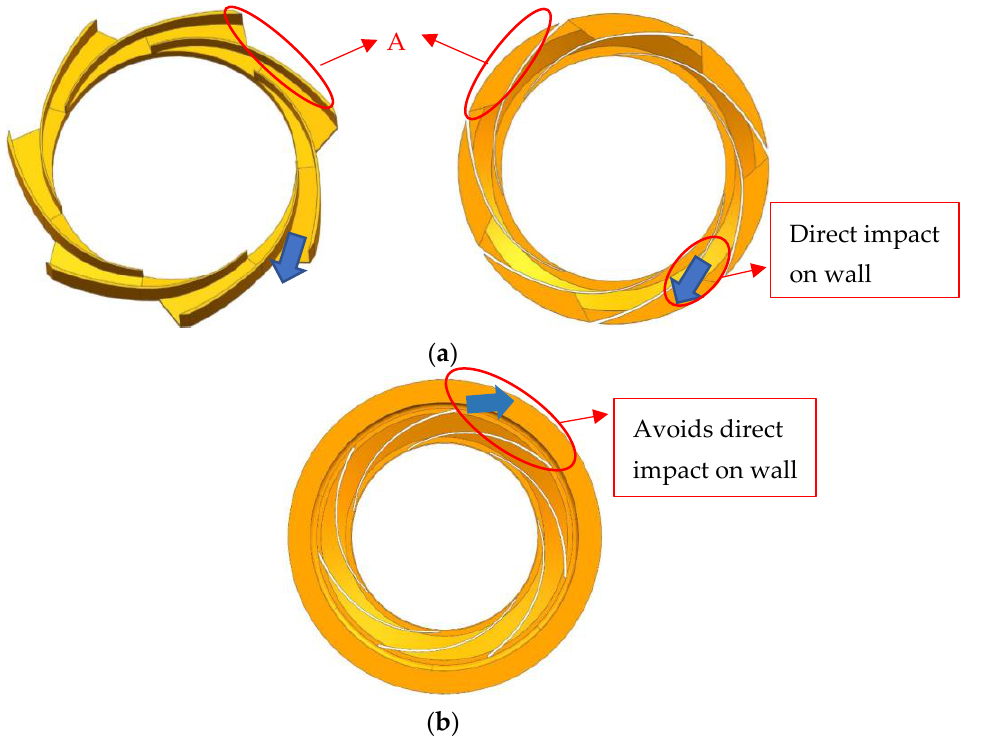
Figure 8. Improvement of the positive guide vane structure. ( a ) Original model guide vane; ( b ) modified guide vane.